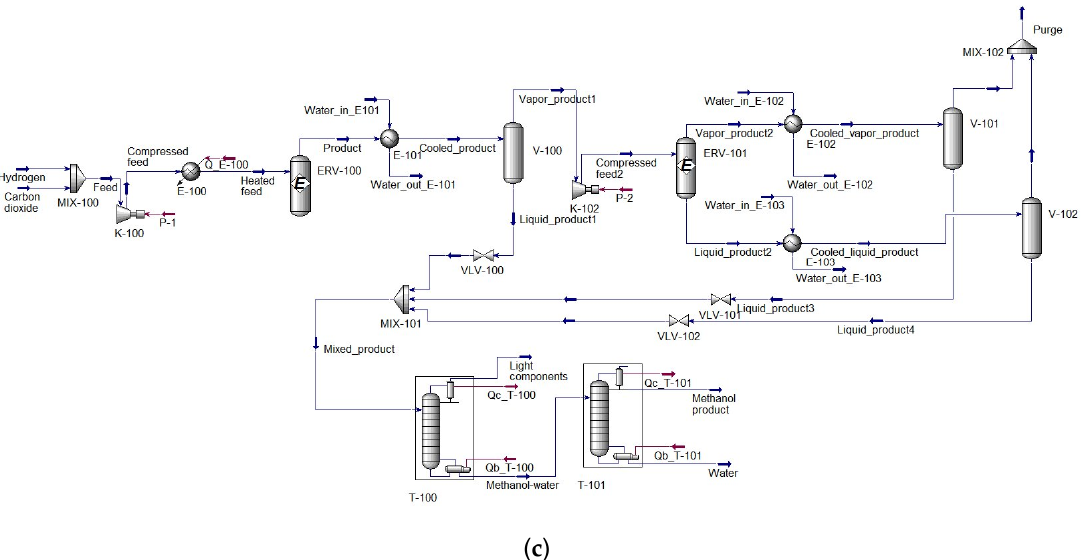
Figure 1 . Process simulation of the methanol production via carbon dioxide hydrogenation : ( a ) configuration I; ( b ) configuration II; and ( c ) configuration III .